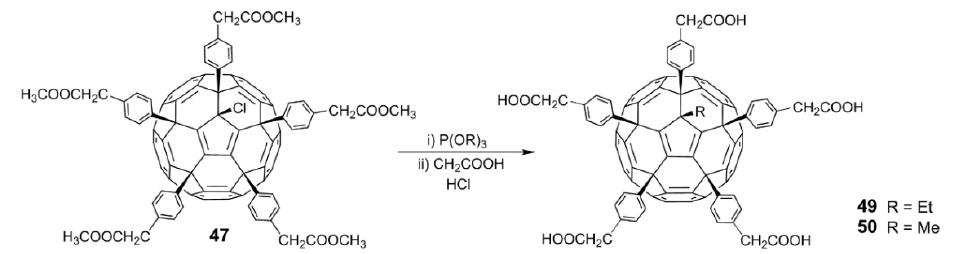
Figure 14. Schematic diagram of synthetic routes of carboxylic fullerene derivatives 49 and 50.